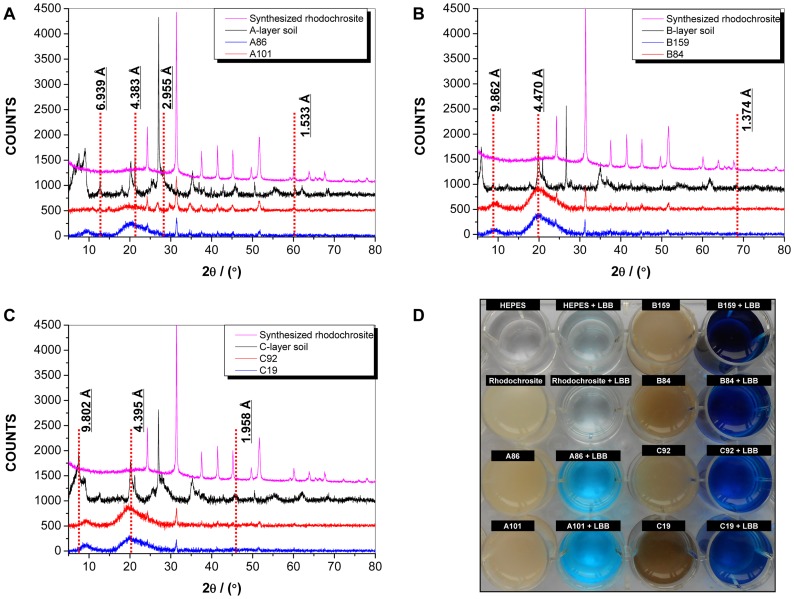
XRD patterns (A, B, and C) and LBB tests (D) of Mn oxides from different depths of soils and Mn oxides from different Mn(II)-oxidizing bacteria.The experiments were performed using dried powdered Mn oxide samples. In A, B, and C, the red dashed lines indicate the overlapping peaks; In C, a HEPES buffer and a synthesized rhodochrosite sample were used as the negative controls.